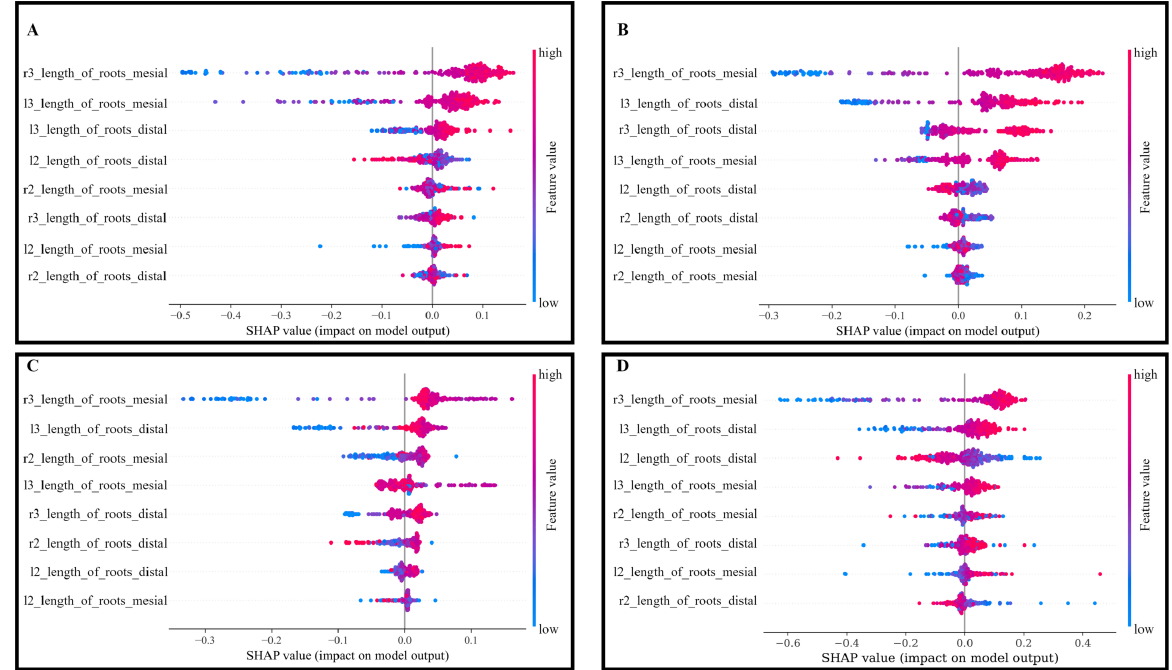
Figure 7. SHAP plots showing feature importance in descending order by bee swarm plot: ( A ) 2–Class classification (SVM): best result; ( B ) 2–Class classification (Random Forest): second best result; ( C ) 3–Class classification (SVM): best result; and ( D ) 2–Class classification (Deep Learning).